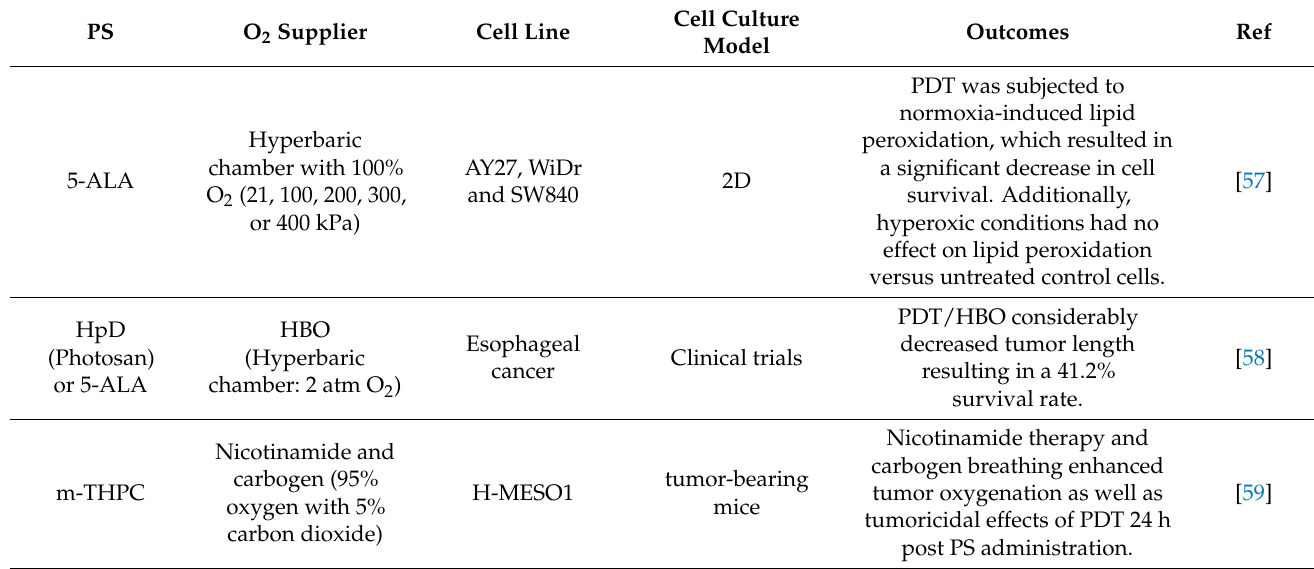
Table 1. An overview of studies that have used HBO for O 2 supply in